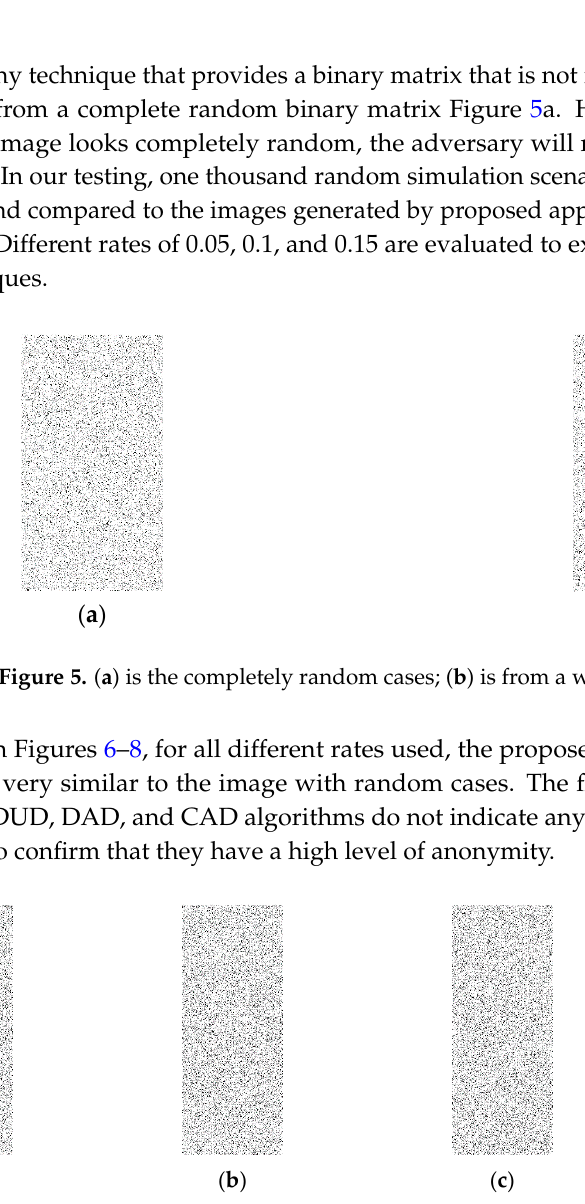
Figure 7. Rate is 0.1, ( a ) is the completely random scenarios; ( b ) is DUD scenarios; ( c ) is DAD scenarios and ( d ) is CAD scenarios, and all images look very similar to each other.